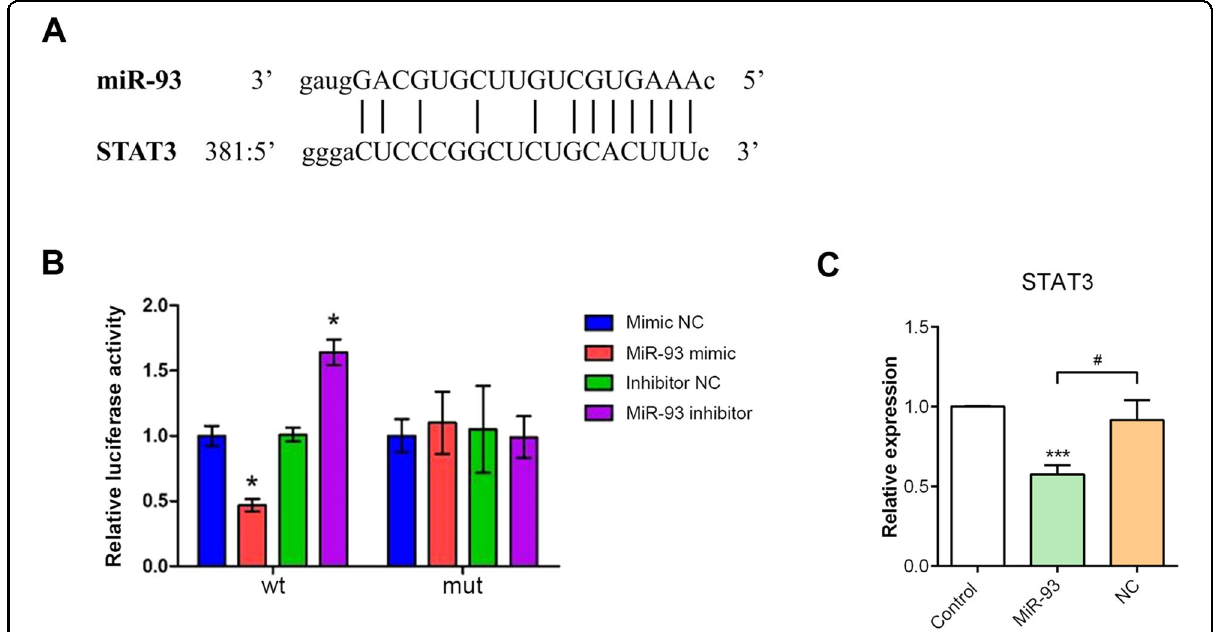
Fig. 2 MiR-93 targeted the STAT3 gene. A Bioinformatics analysis predicted interactions between miR-93 and STAT3. The 3 ′ -UTR of STAT3 contains a conserved binding site for miR-93. B The miR-93-dependent change in luciferase activity was abolished after the introduction of mutations in the STAT3 binding site, indicating that STAT3 gene is a target of miR-93. C As measured by qRT-PCR, miR-93 mimic transfection signi fi cantly decreased the STAT3 mRNA level in primary retinal microglial cells. Compared with the NC: * P < 0.05. Compared with the control: *** P < 0.001. Compared with the miR-93 transfection group: # P < 0.05. n = 3 independent cultures. NC negative control, wt wild type, mut mutant